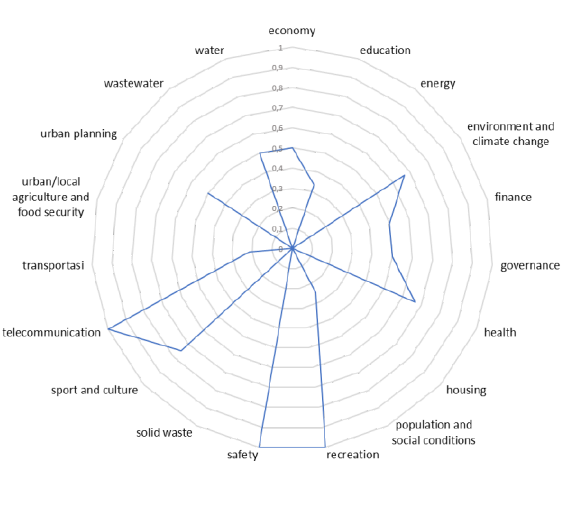
Figure 2. Sectors that can play a role in inhibiting the spread of the pandemic by expert judgement